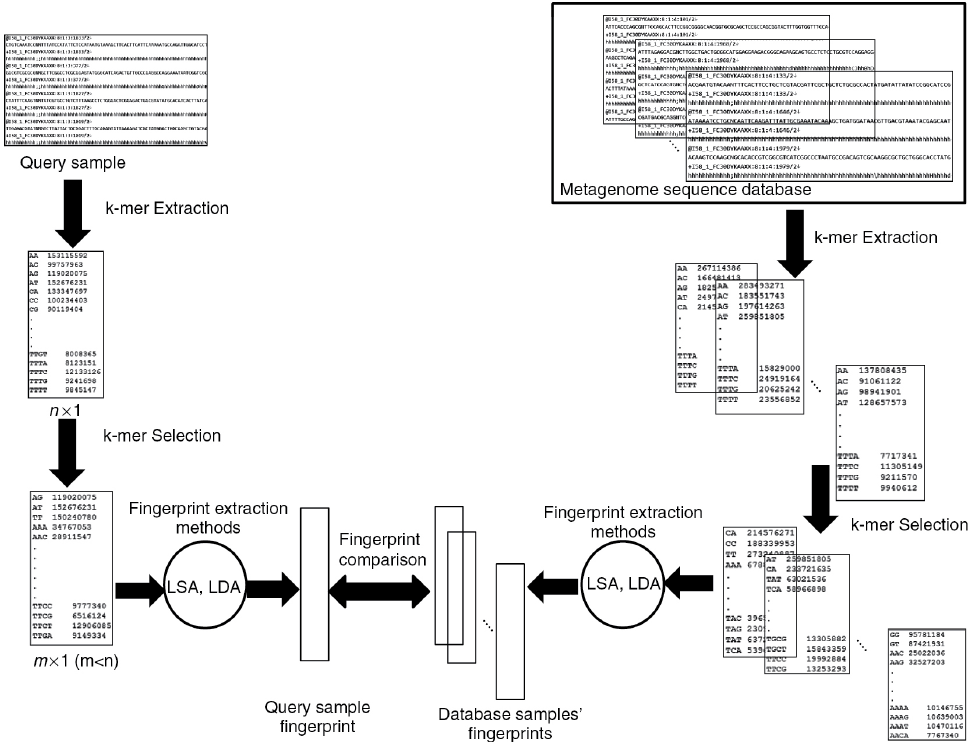
Figure 1: An overview of proposed retrieval